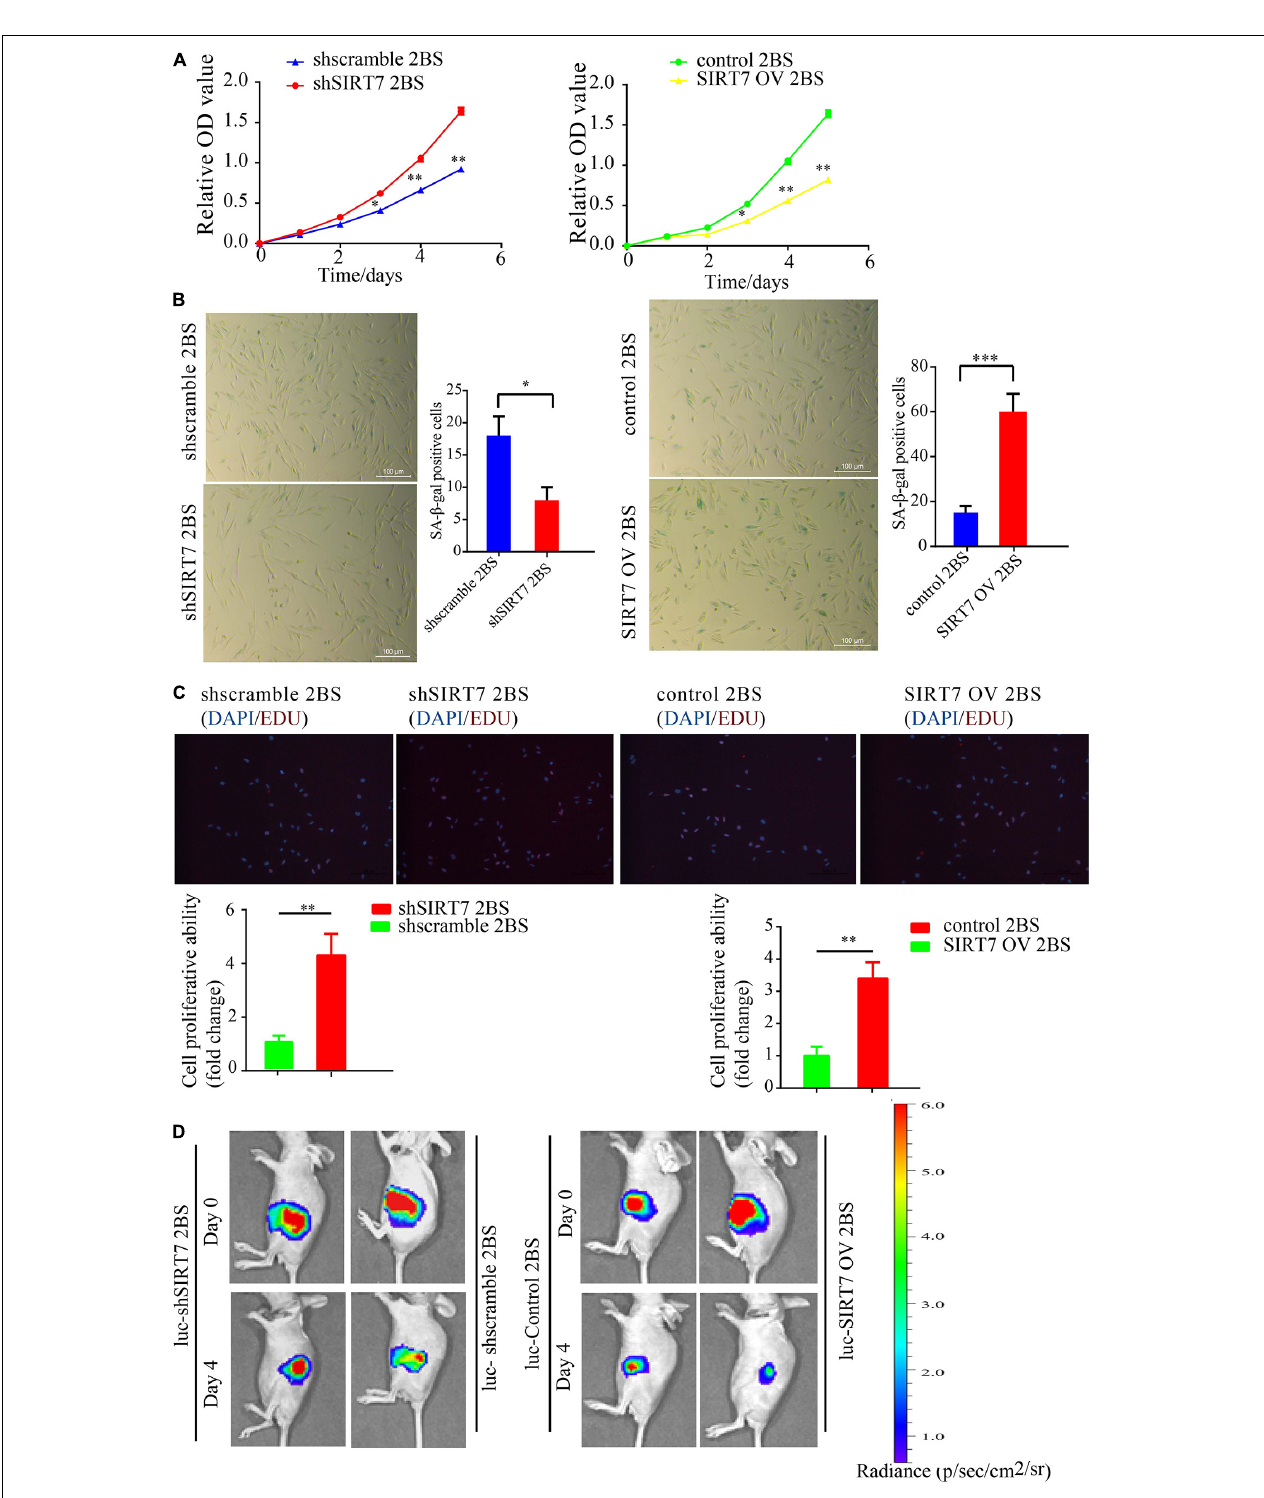
FIGURE 2 | The effect of SIRT7 on 2BS fibroblast senescence. (A) CCK8 evaluated the proliferative ability of 2BS fibroblasts with SIRT7 knockdown or overexpression (OV); the experiments were repeated three times. (B) SA- β -gal staining of 2BS fibroblasts with SIRT7 knockdown or overexpression, scale bar = 100 µ m; the experiments were repeated three times, ∗∗ P < 0.01. (C) EdU incorporation analysis of proliferative ability of SIRT7 knockdown or overexpression 2BS fibroblasts, scale bar = 200 µ m; the experiments were repeated three times. (D) The VIS spectrum imaging system was used to analyze the luciferase activity 4 days after SIRT7 knockdown or overexpression 2BS fibroblast transplantation. All experiments were repeated three times independently, and statistical analysis was performed by t -test, ∗ p < 0.05, ∗∗ p < 0.01, and ∗∗∗ p < 0.001.